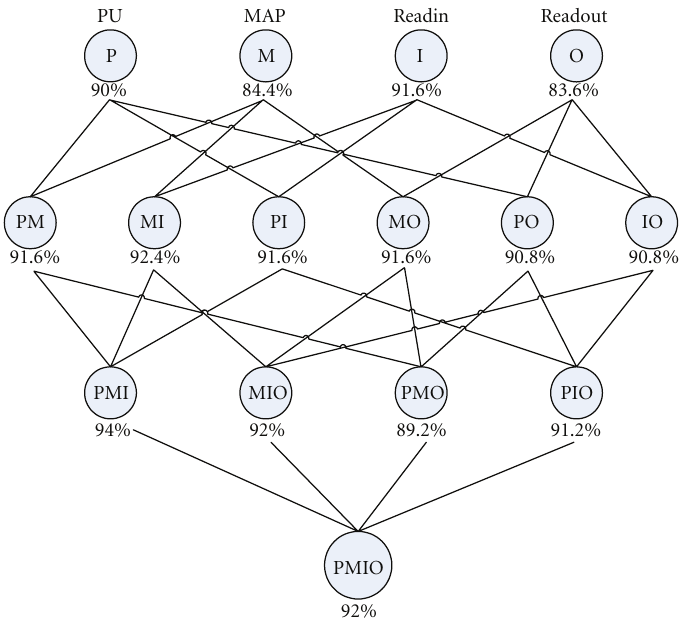
Figure 9: Learning performance of each learning mode.